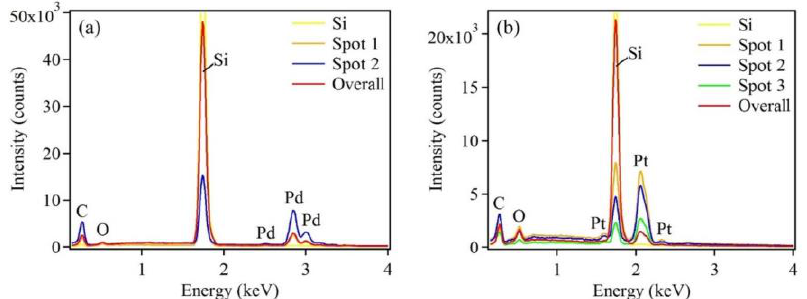
Figure 5. EDX patterns of ( a ) Pd and ( b ) Pt nanostructures deposited on Si substrates after five deposition cycles, showing the presence of Pd and Pt, respectively. EDX patterns recorded from individual nanostructures are presented as spots 1–3.